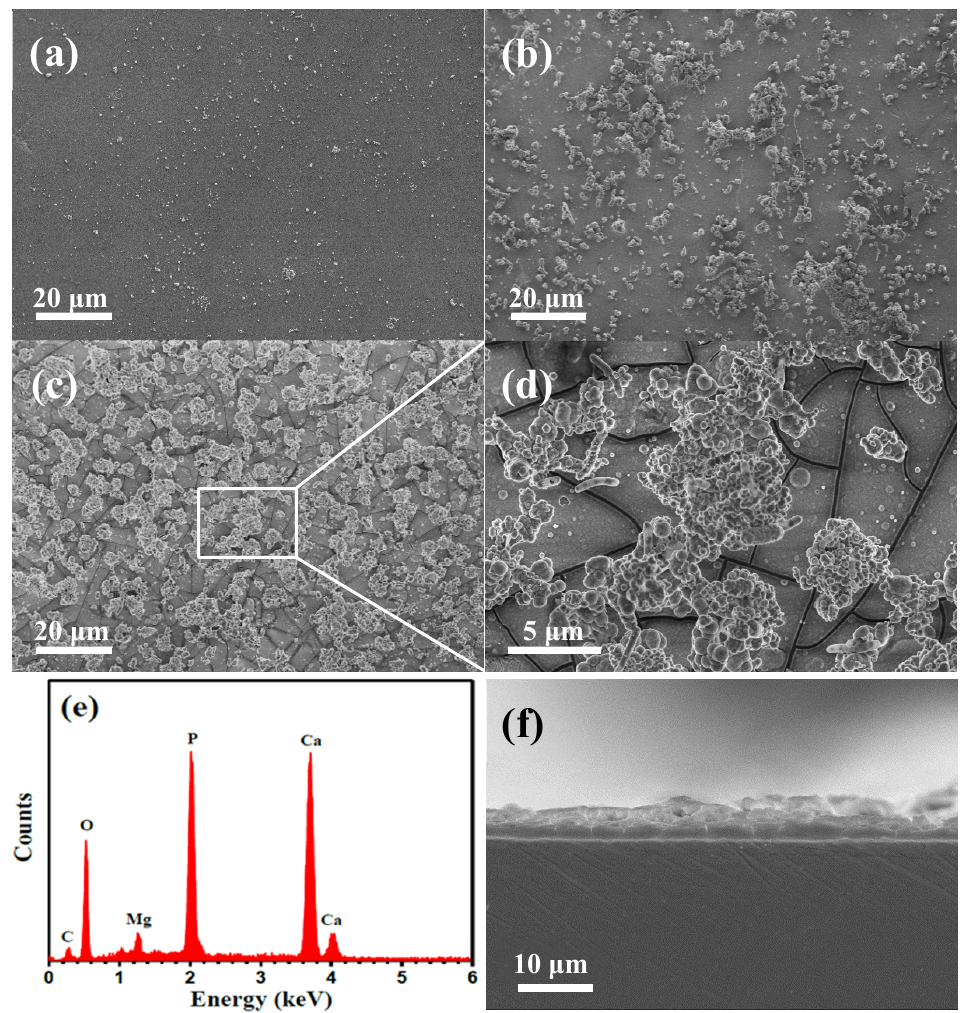
Figure 10. SEM micrographs of: ( a ) uncoated Ti-6Al-4V; ( b ) commercially pure Ta; and ( c , d ) β -Ta coating after soaking in Hank’s solution for seven days; ( e ) EDS spectrum and ( f ) cross-sectional SEM micrograph of the apatite layer formed onto the β -Ta coating.